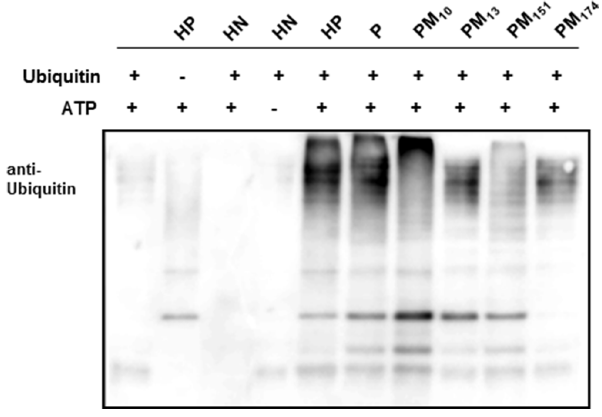
Figure 2. Auto-ubiquitination activity of recombinant parkin proteins. E3 ligase activity of purified recombinant parkin proteins was assessed by an auto-ubiquitination assay. 1 m g of each of the indicated proteins was incubated for 1 hr at 37 u C with 1 m M E1, 50 m M E2, 1 mM histidine-tagged Ubiquitin and 10 mM Mg-ATP, and the reaction products were fractionated by SDS PAGE and immunoblotted against an anti-Ubiquitin antibody. Parkin proteins (P, HP, PM 10 , PM 13 , PM 151 and PM 174 ) are described in Figure 1. Samples without individual components or containing an unrelated protein, 6xHis-NM23 (HN), were used as negative